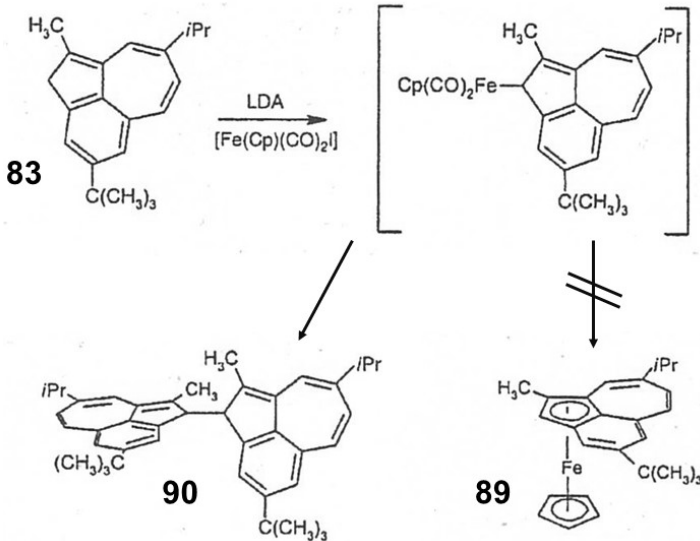
Scheme 33. Preparation of 2-phenyl-11b H -dibenz[ cd , h ]azulene, 92 , from the bromoallene 91